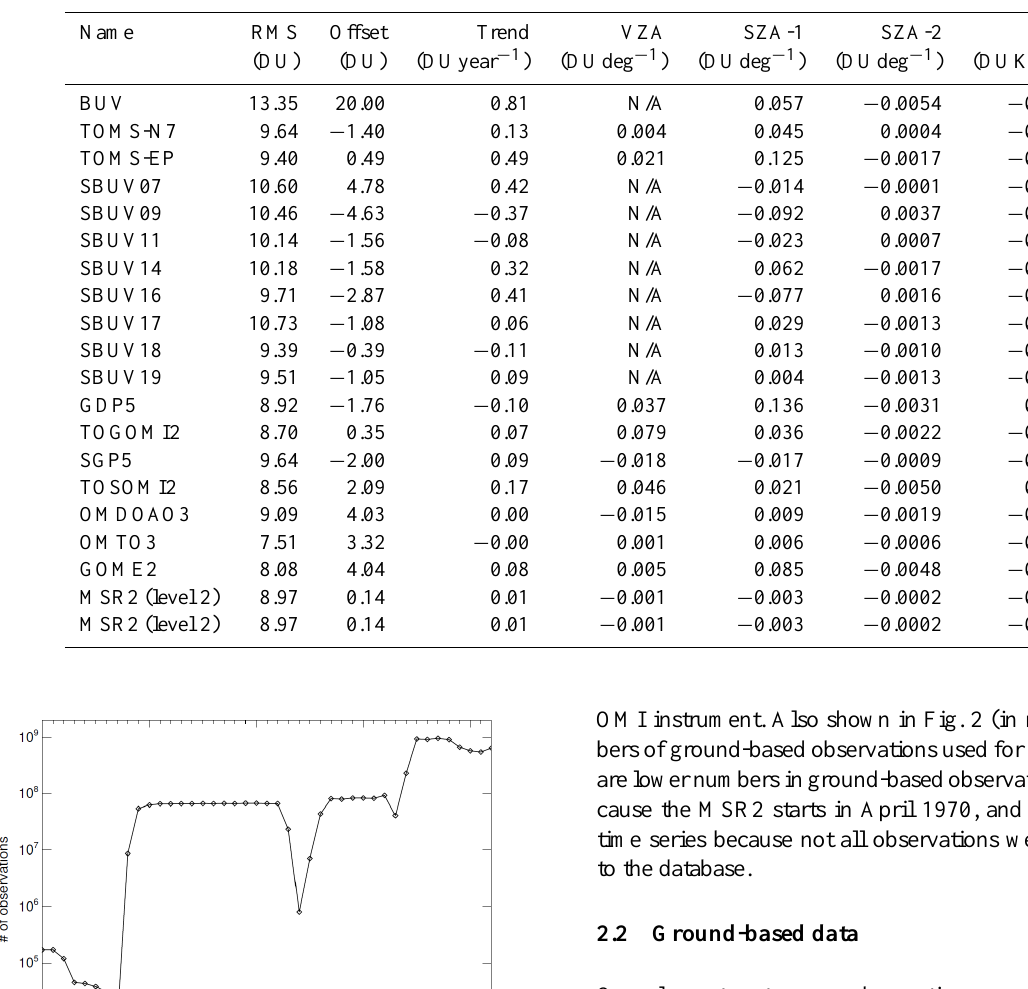
Table 2. Regression coefficients (expressed as corrections) for the various ozone data sets. The columns show (1) name; (2) RMS original data; (3) offset correction; (4) trend correction; (5) viewing zenith angle correction; (6) linear solar zenith angle correction; (7) second-order solar zenith angle correction; (8) effective ozone temperature correction. The last line shows the consistency check for the entire MSR2 level 2 data set after applying the corrections.